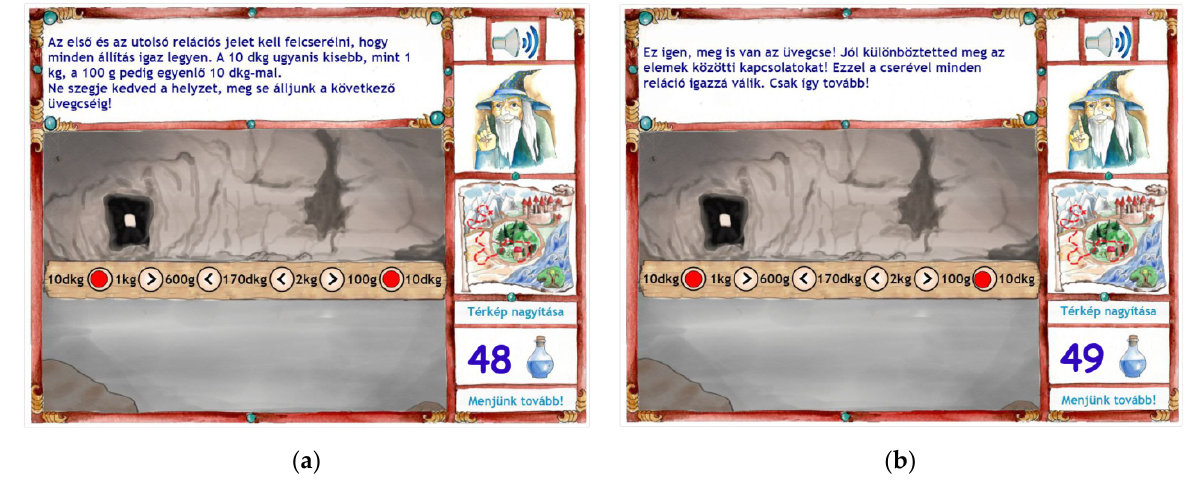
Figure 4. Samples for feedback in the training program at the end of the feedback loop. ( a ) In case of a third unsuccessful trial of the learning task, instruction: The first and the last relation symbols should have been swapped to make all the statements true. Namely, 10 dg is smaller than 1 kg, and 100 g is equal to 10 dg. Don’t be discouraged; let’s get the next potion of water of life. ( b ) In case of the correct solution of the task: Well done, you’ll get the bottle. You have differentiated the relations between the objects correctly. With this swap all the statements are true. Keep it up.